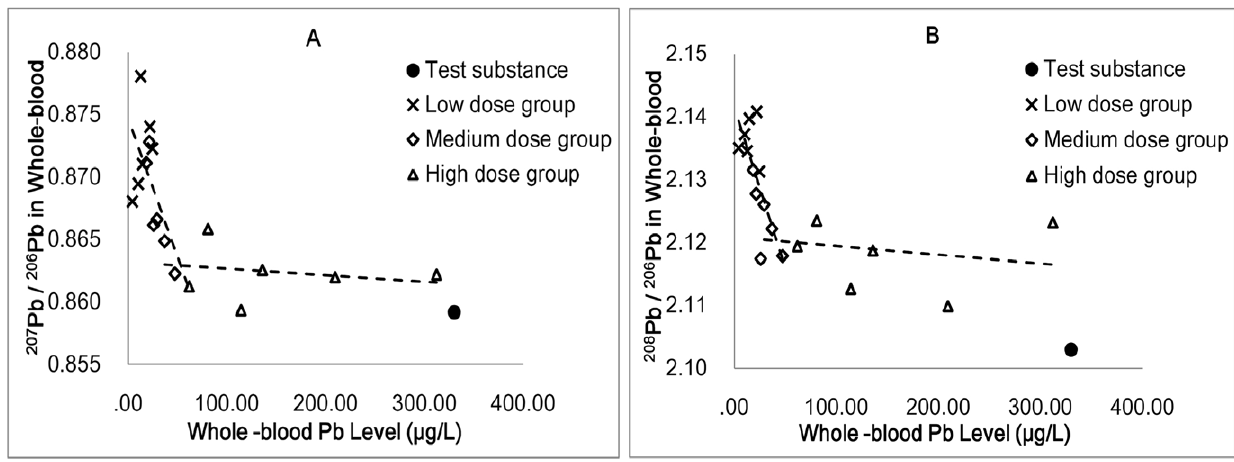
Figure 2. Whole-blood Pb concentration versus isotope ratios in blood for experimental dose groups (n=18). Figure 2A. isotope ratio of 207 Pb/ 206 Pb. Figure 2B. isotope ratio of 208 Pb/ 206 Pb.